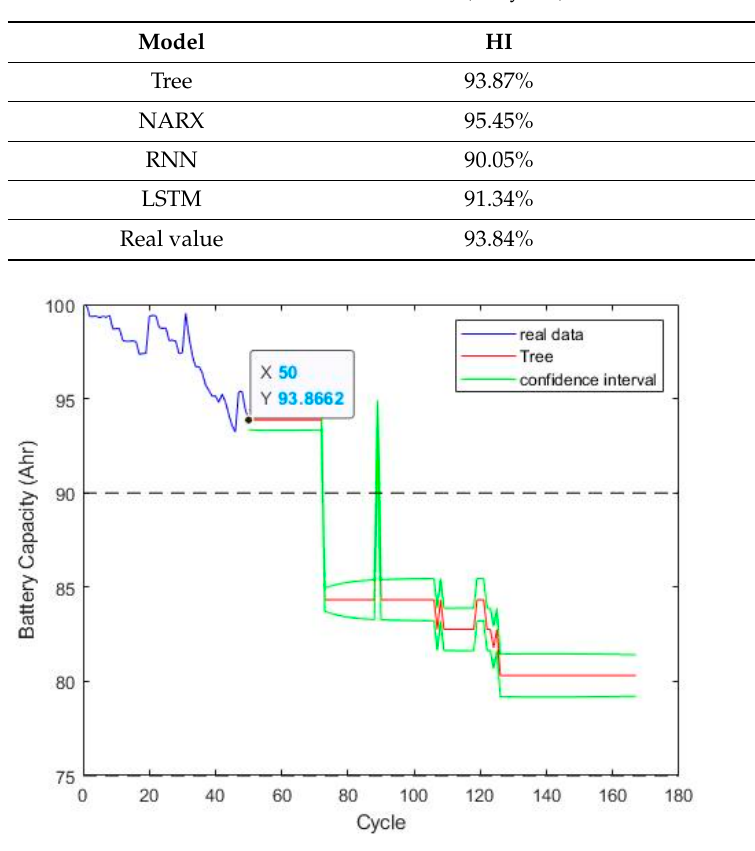
Figure 13. Prediction results of Decision Tree (after 50 cycles).